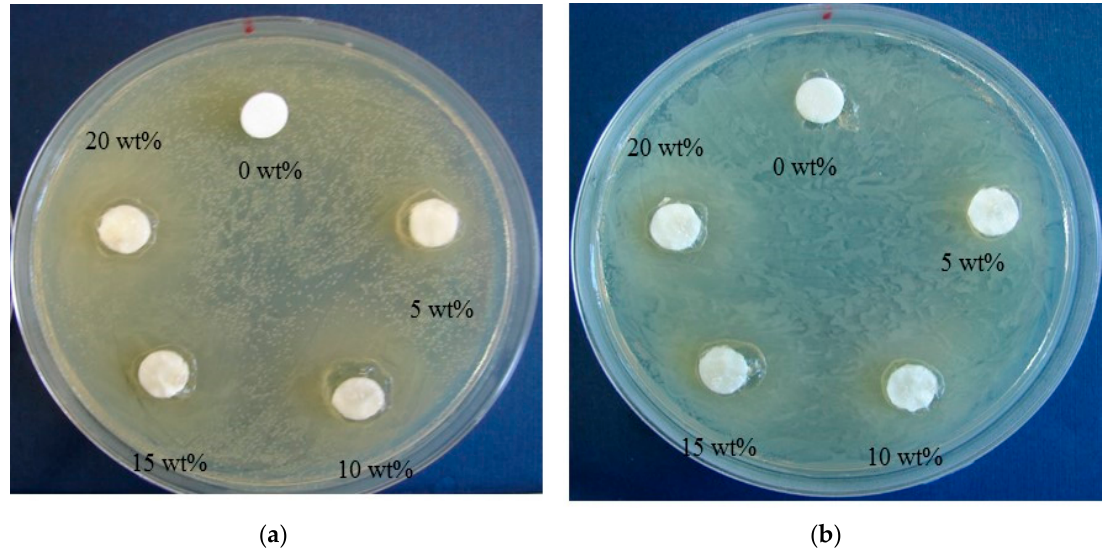
Figure 5. Antibacterial image of CH–CMC hydrogels with different content of honey against S. aureus ( a ) and E. coli ( b ). Table 1. Antibacterial activity CH–CMC hydrogels; (-) without inhibition, (+) d r = 1.0 mm, (++) d r = 2.0 mm, (+++) d r = 3.0 mm, where d r is the diameter of the inhibitione zone. CH–CMCInhibition Zone